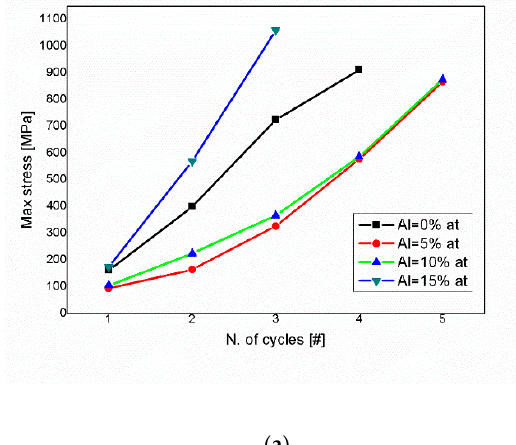
Figure 6. Compression behavior of CuZr based alloys, tested at room temperature: stress – strain after stabilization of Cu 50 Zr 50 alloy ( a ); and Cu (50 − x) Zr 50 Al x alloys with Al = 5, 10, 15 at. % ( b–d ), respectively. The stresses and strains are compressive.